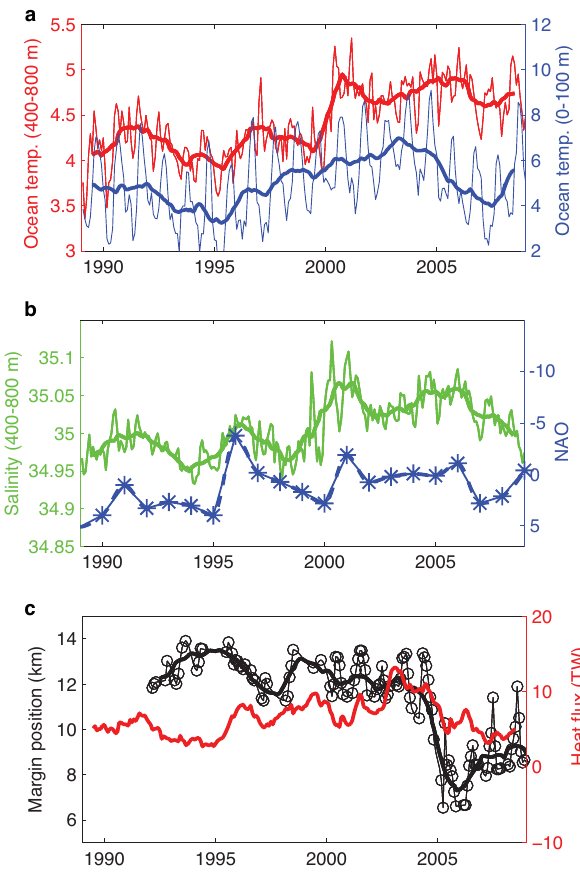
Fig. 7. (a) Time series of potential temperature as shown in Fig. 5, but averaged for 0–100m (blue) and 400–800m (red). Solid bold lines are 12-month-moving averages of monthly mean values. (b) Same as (a) , but for salinity at the 400–800m level (green). Dashed blue line and asterisk show the extended NAO winter in- dex. (c) Monthly margin positions of KG (black circles) derived from satellite imagery as described in text. Black bold line is the 12-month-moving average. The red line is the 12-month-moving average of heat flux calculated at transect shown in Fig. 1a and with reference to 0 ◦ C. The heat flux is positive northward, which is into KTr and towards the